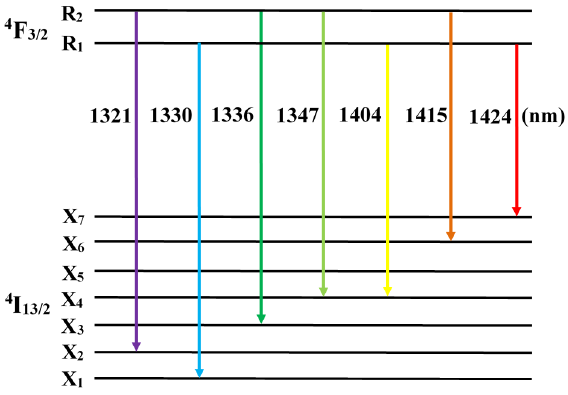
Figure 6. Energy-level transitions of 4 F 3/2 → 4 I 13/2 excited at 808 nm for Nd:GYSGG.